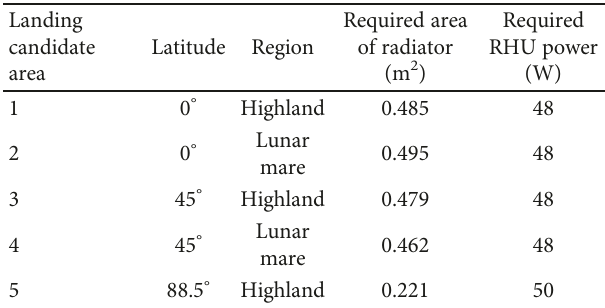
Figure 6: Temperature pro fi les of the lunar lander with and without RHU when applying a shutter with MLI and black paint on the SSM radiator. Table 6: Optimal radiator area and RHU power for a lunar lander at various landing candidate areas.